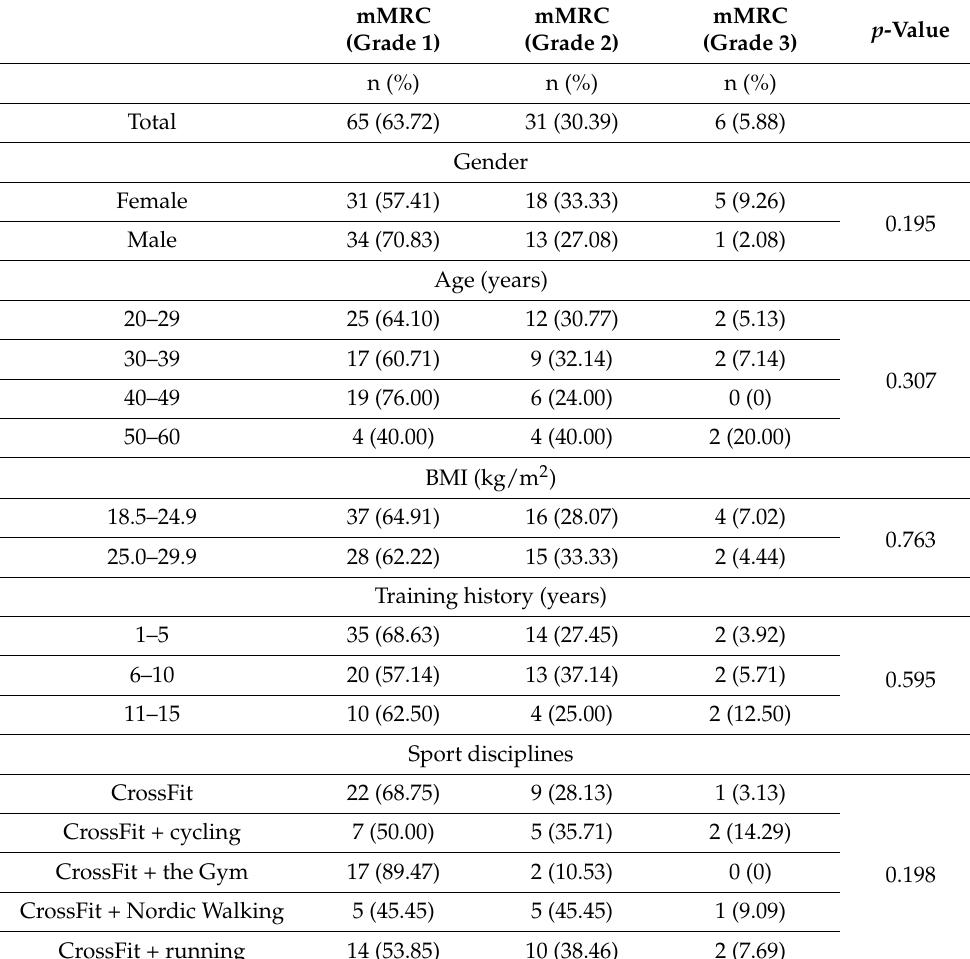
Table 3. Results of the assessment of the severity of dyspnea according to the mMRC questionnaire with a statistical